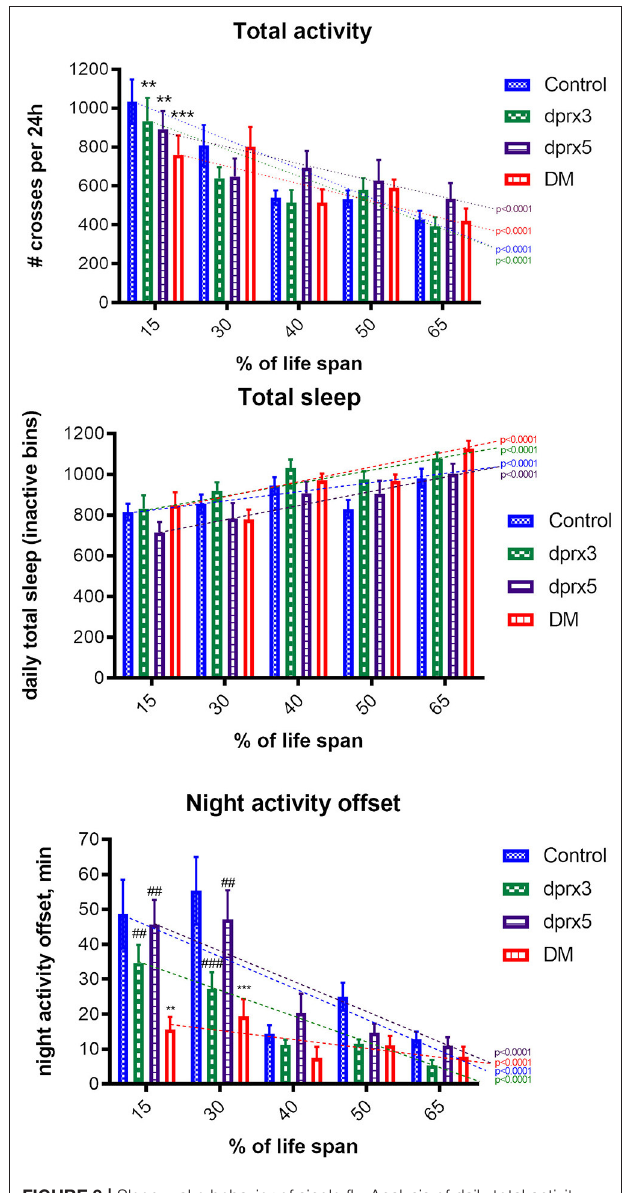
FIGURE 3 | Sleep-wake behavior of single fly. Analysis of daily total activity, daily total sleep and night activity offset in control (Control), single ( prx3 and prx5 ) and Prx double mutants was undertaken in male flies at different physiological ages ( Supplementary Table 2 ). All measurements were performed from Zeitgeber time 0 (ZT0) to ZT24. Results are means ± SEM ( n = 14–16) for each time point of control and single mutants. The dotted lines represent trend lines of changes during aging, and P -values are shown for each fly line. There was a significant decrease in 24-h total activity during aging in all four fly lines ( p < 0.0001). Statistical analysis has been done by two-way ANOVA with Bonferroni post-tests: Control vs. dprx3, Control vs. dprx5 at 15% life span ( p < 0.01); Control vs. DM at 15% life span ( p < 0.001). No statistically significant difference in the changes during aging was found between Control, the double and single mutant lines. The Bonferroni post-test showed a significant difference only between the mean values at 15% of life span. There was a gradual increase in 24-h total sleep during aging in all four lines resulting in statistically significant differences between flies at 15 and 65% of their life spans ( p < 0.0001). There was no statistically significant difference